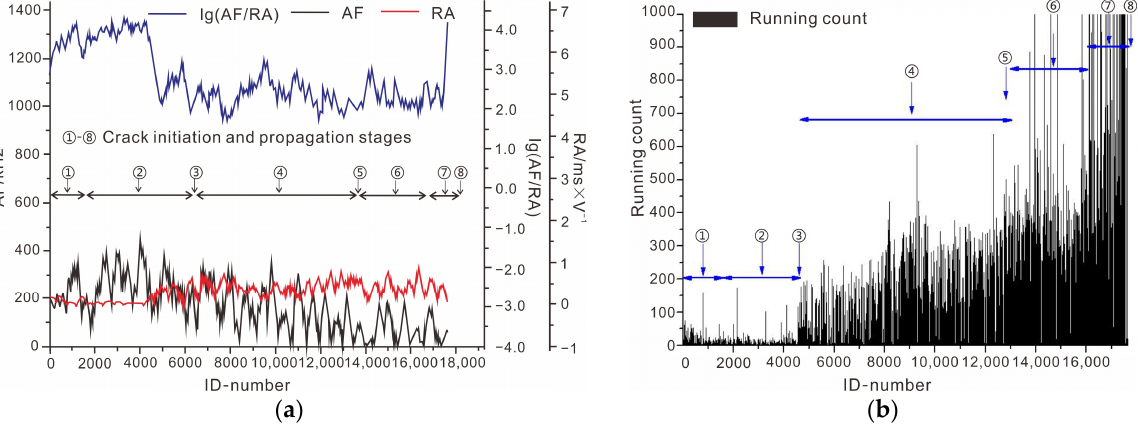
Figure 9. Parameters of acoustic emission of rock sample with single crack. ( a ) Curve of parameters of acoustic emission; ( b ) running count of intact rock sample.